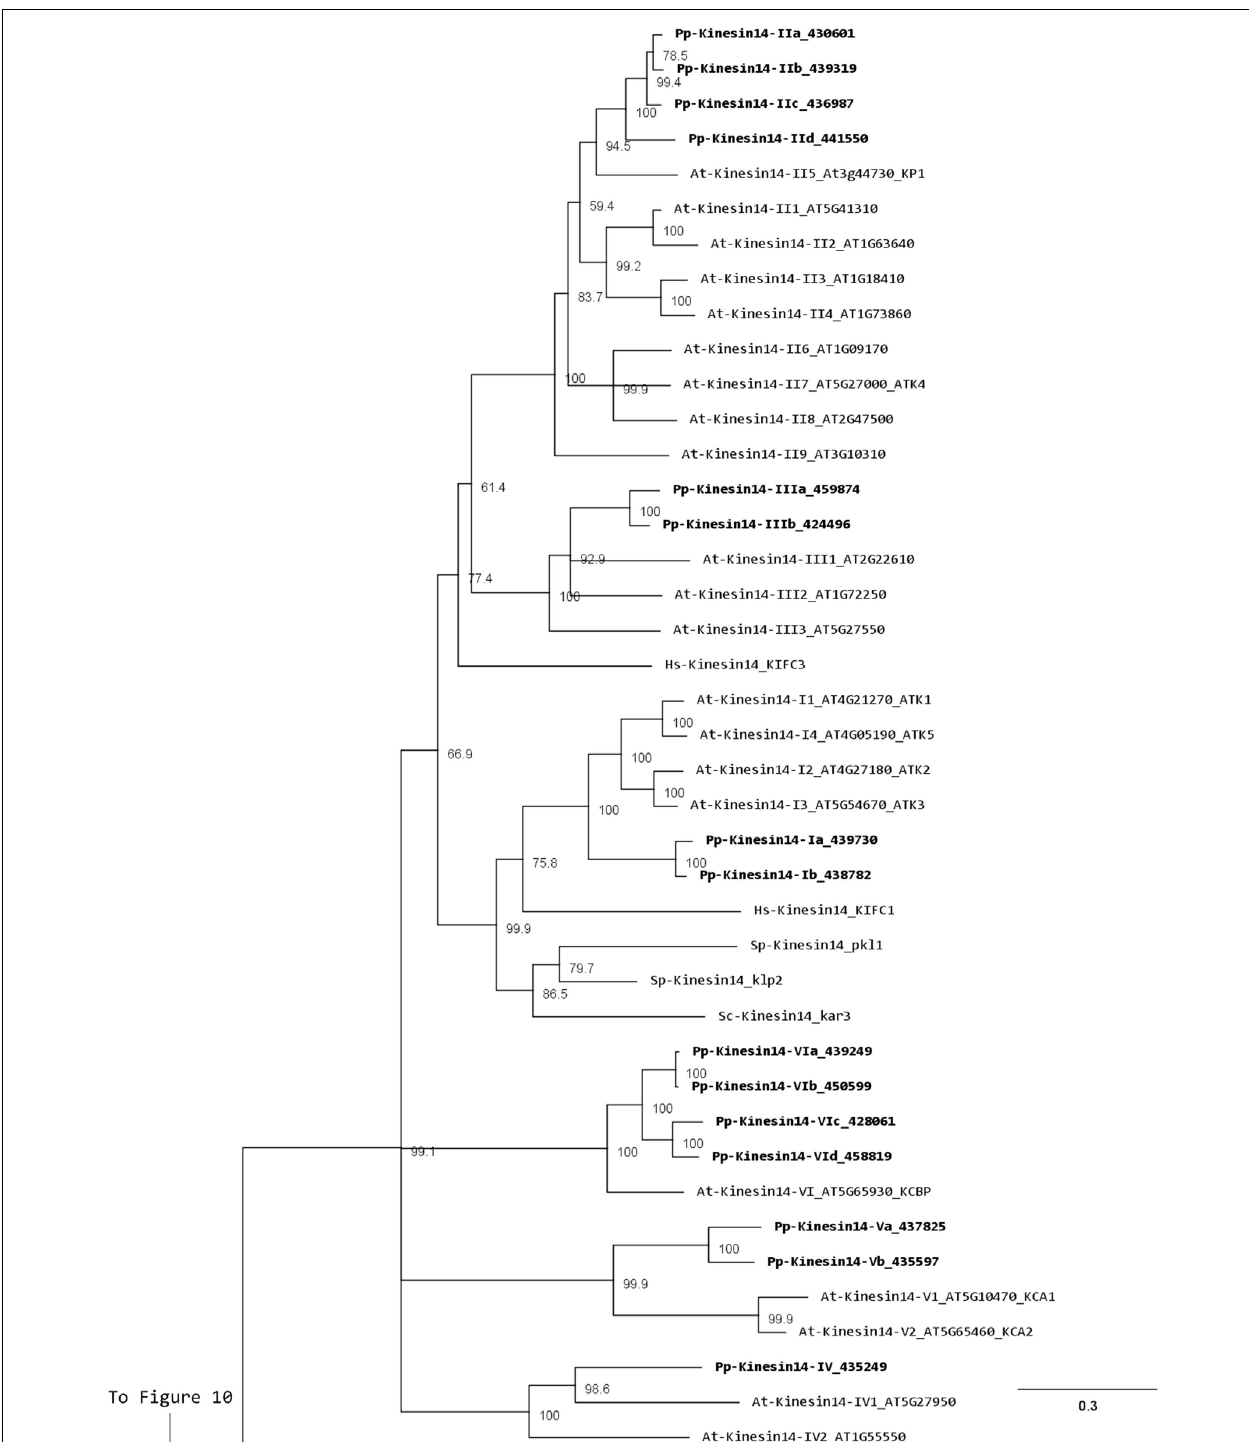
the statistical support of values above 50%.The scale shows the estimated branch length corresponding to the number of substitutions per site.The Physcomitrella numbers correspond to the Phypa number uniquely associated with each gene model (version 1.6) at